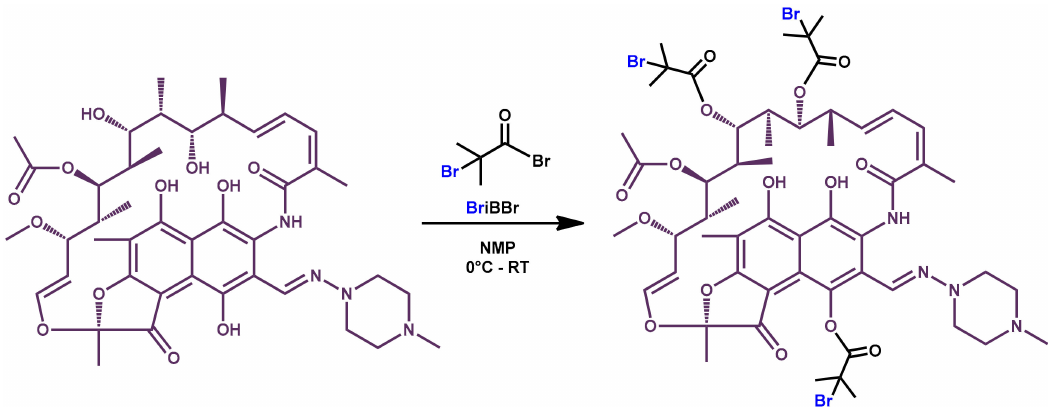
Figure 1. Synthetic route for the preparation of rifampicin-based ATRP macroinitiator ( M n = 1269.94, Ð =